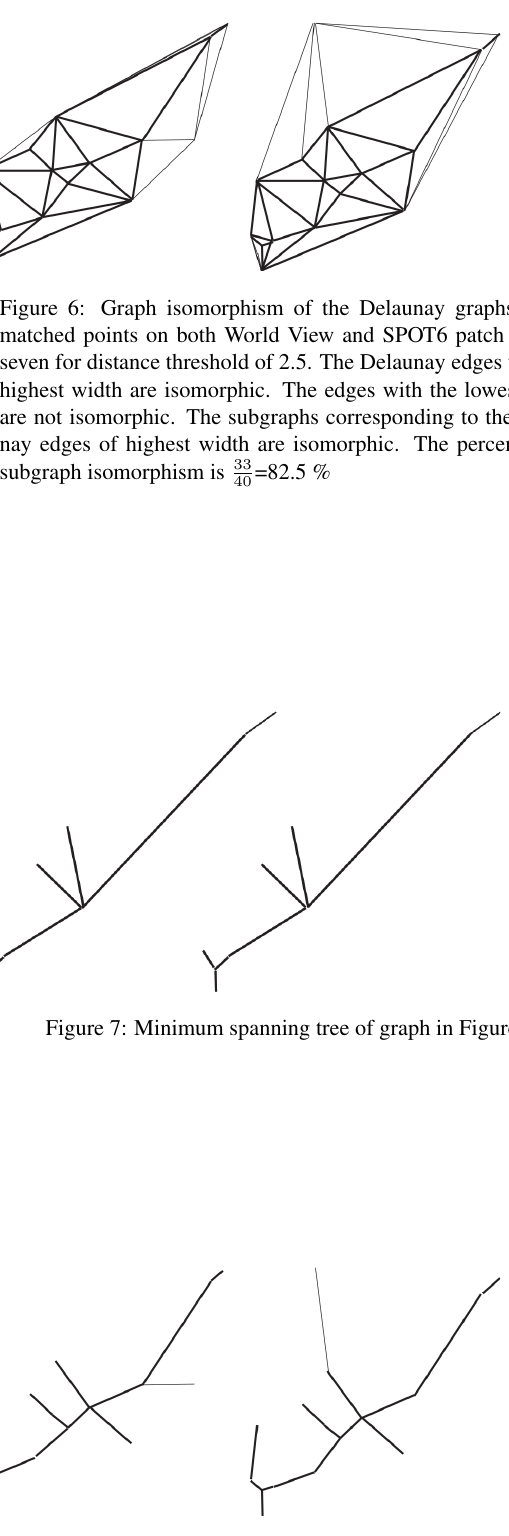
Figure 8: Minimum spanning tree of graph in Figure